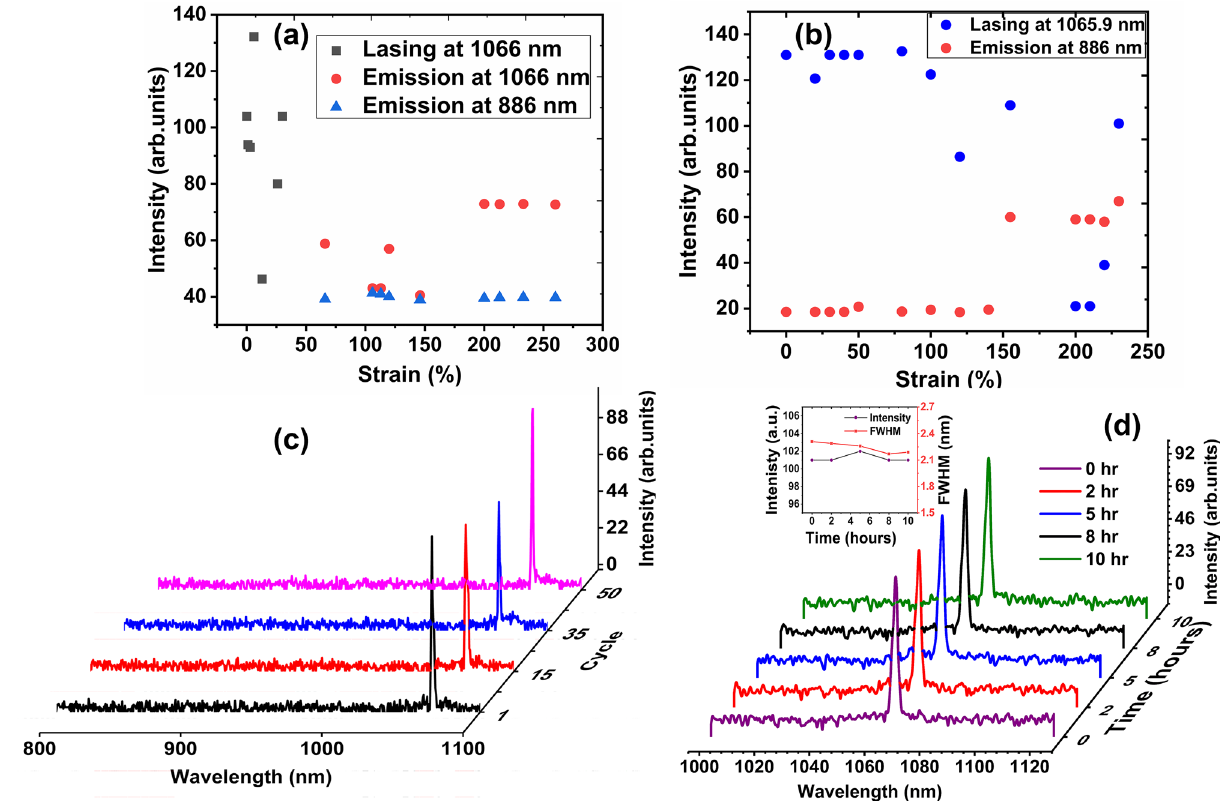
Figure 4. ( a ) The spectroscopic response intensity of the PC0.2 device for different strain values up to 260% with 532 nm laser excitation. Each point in Figure is an average of the peak spectral power density over different strain values. Lasing ceases for strain values above ~ 60% and only amplified spontaneous emission (ASE) can be observed instead, with one new peak appearing at 886 nm, ( b ) spectroscopic response intensity of the PC0.4 RL device for different strains up to 230%, ( c ) RL emission of PC1.0 by applying a maximum strain of 100% for several cycles, ( d ) the PC1.0 RL emission as a function of time of continuous operation, the inset shows the intensity and linewidth (FWHM) of the lasing emission as a function of time of continuous